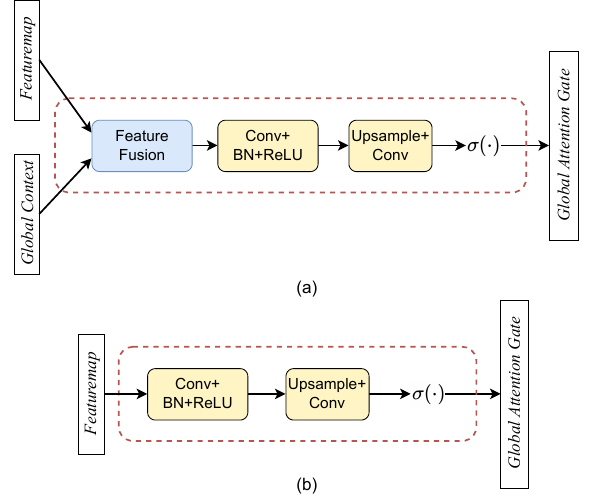
Figure 3. Illustration of global attention gate: ( a ) GAG_v1 and ( b )